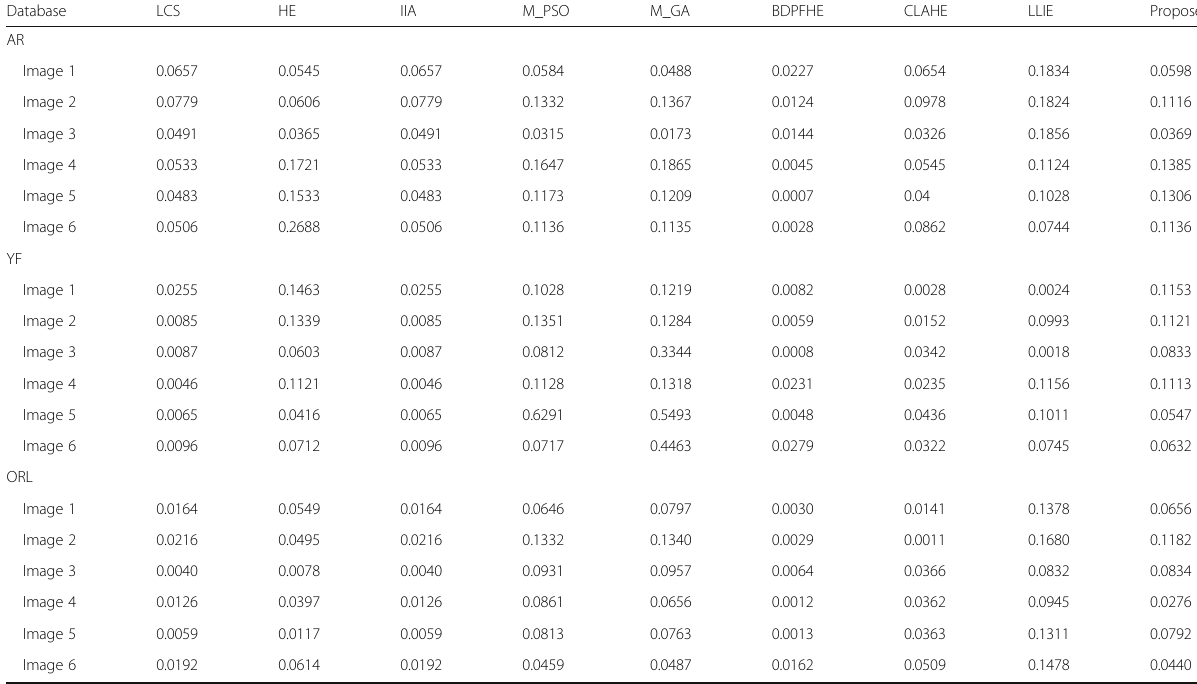
Table 8 AMBE value comparison between results obtained using different enhancement methods on three different standard benchmark face datasets